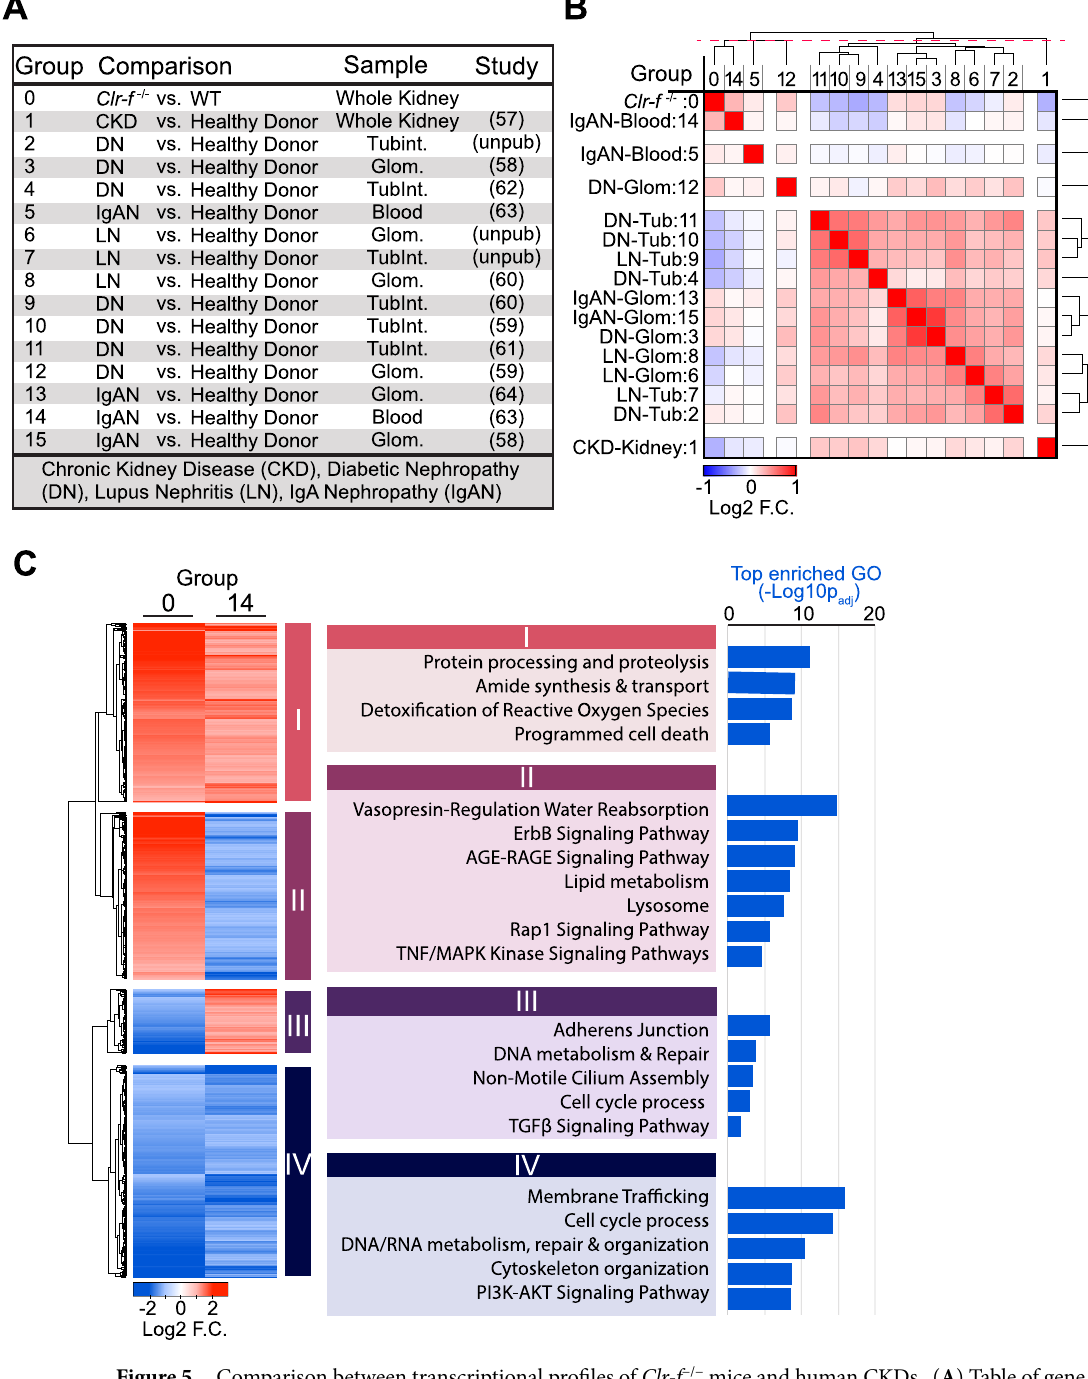
Figure 5. Comparison between transcriptional profiles of Clr-f −/− mice and human CKDs. ( A ) Table of gene expression profile data sets of 15 human renal disorders vs. 13-week-old Clr-f −/− mice. The reference source for the human expression profile data set sources is indicated by the Study column. ( B ) Similarity matrix showing hierarchical clustering of differential gene expression profiles in panel ( A ). Red-dashed line within dendrogram indicates the level of matrix cluster separation. ( C ) Comparison of 4531 DEGs (Log2 FC; P adj. < 0.05) of 13-week-old Clr-f −/− mice (group 0) and IgAN patients. Gene set enrichment from 4 DEG clusters: (I) upregulated in both Clr-f −/− mice and IgAN patients, (II) upregulated in Clr-f −/− mice and downregulated IgAN patients, (III) downregulated in Clr-f −/− mice, and upregulated IgAN patients, and (IV) downregulated in both Clr-f −/− mice and IgAN patients. Heat maps were constructed using Morpheus (https:// softw are. broad insti tute. org/ morph